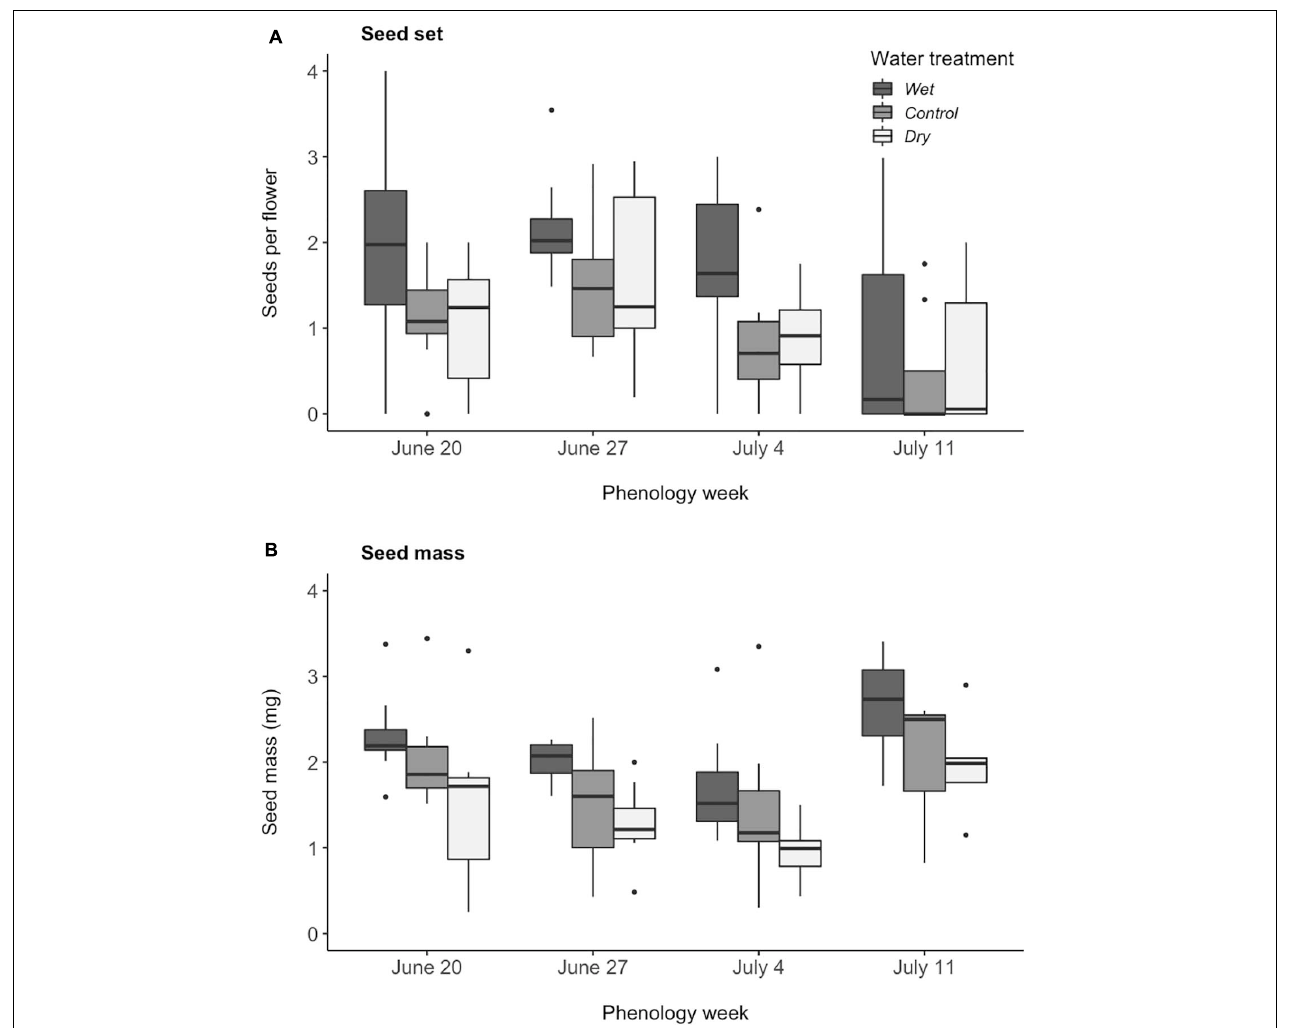
FIGURE 5 | Effects of experimental variation in soil moisture and flowering phenology on (A) seeds set per flower, calculated as (number of mature seeds/number of flowers), and (B) seed mass, calculated as (mass of collected seeds/number of collected seeds) ( N = 114). (A,B) Wet differed from control and dry treatments (Tukey pairwise comparison among water treatments, P < 0.005). (A) Week 4 (July 11) differed from the first 2 weeks (June 20 and 27) (Tukey pairwise comparison among phenology weeks, P < 0.05). Boxplots follow the same conventions as in Figure 1